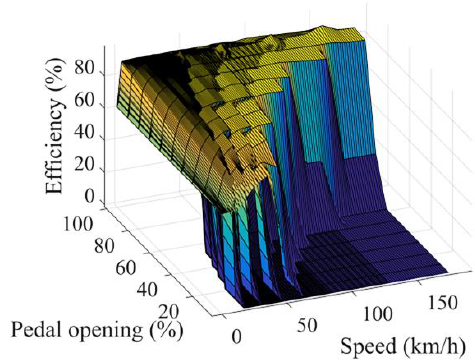
Figure 4. The efficiency surface of each gear.